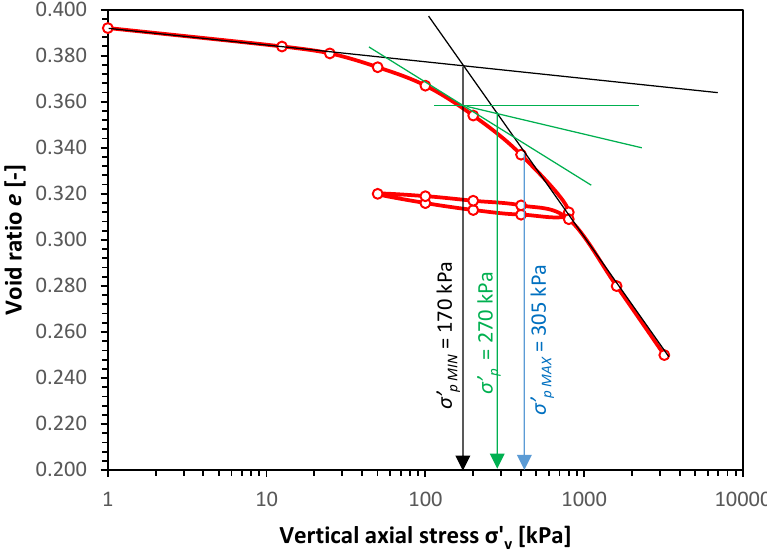
Figure 4. Results of oedometric tests on compacted in optimal moisture content clay sample.